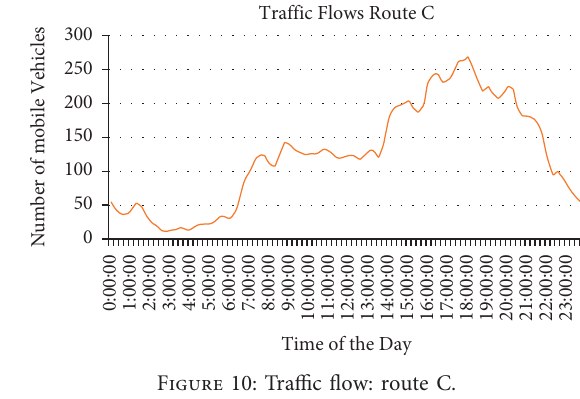
Figure 10: Traffic flow: route C.